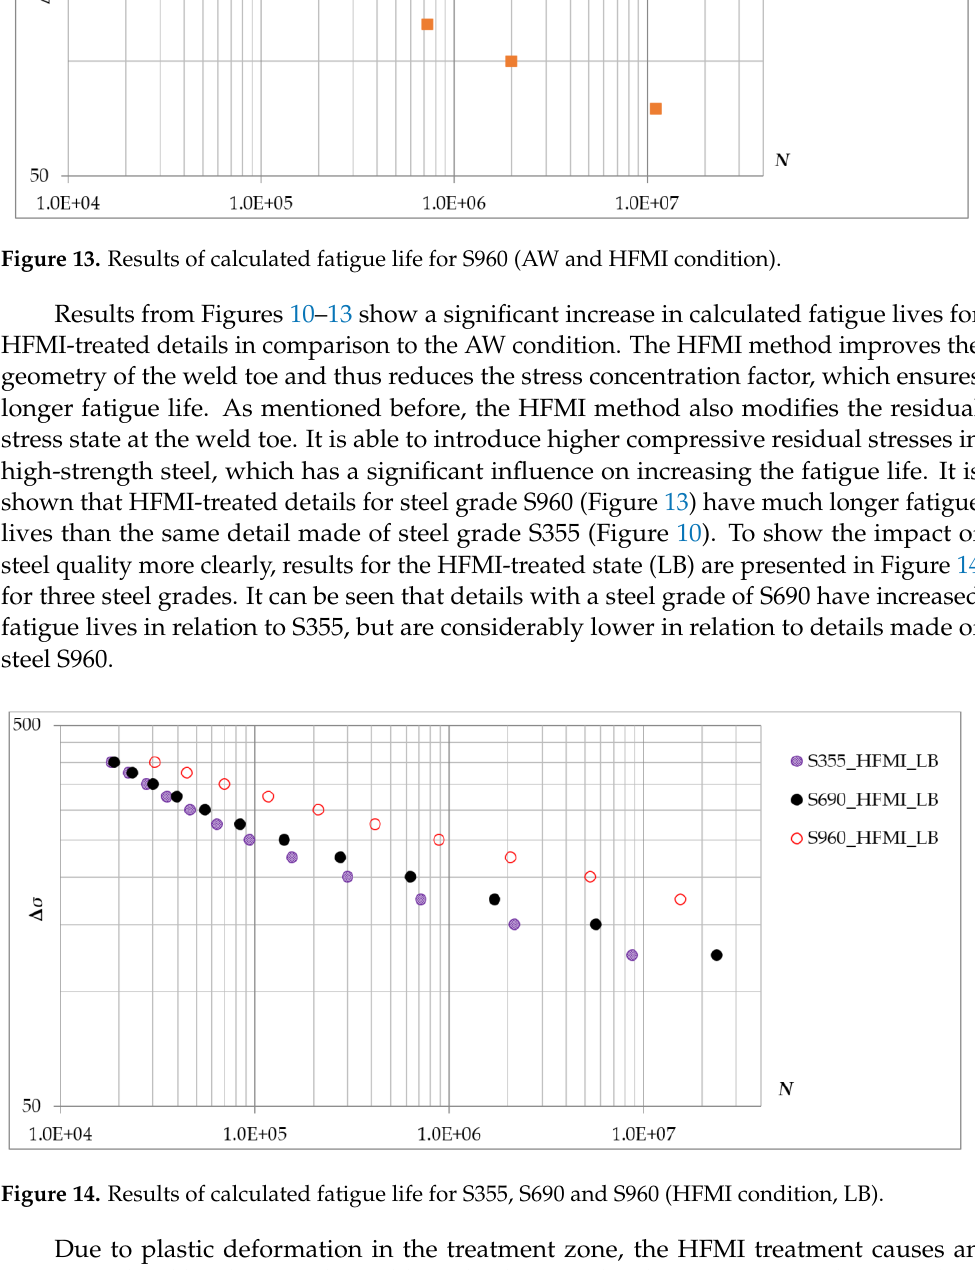
Figure 12. Results of calculated fatigue life for S690 (AW and HFMI condition).